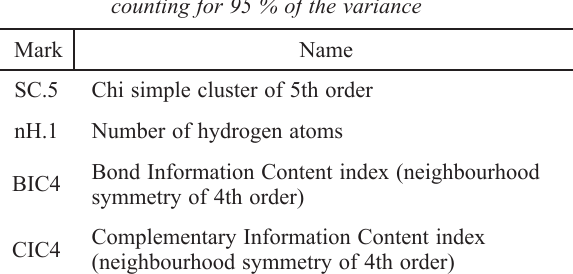
Table 2 – The most important molecular descriptors ac- counting for 95 % of the variance